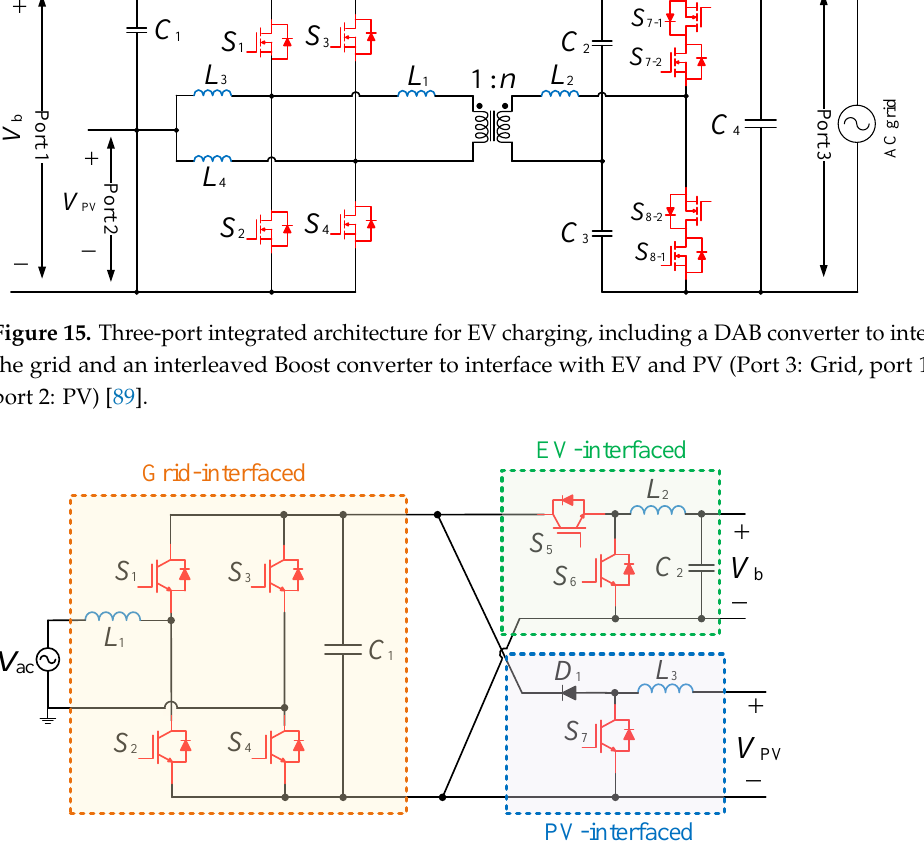
Figure 16. Three-port integrated architecture for EV charging with an AC–DC bidirectional full- bridge converter to interface with the grid, a DC–DC bidirectional half-bridge converter at EV side, and a DC–DC unidirectional half-bridge converter for the PV port [86].